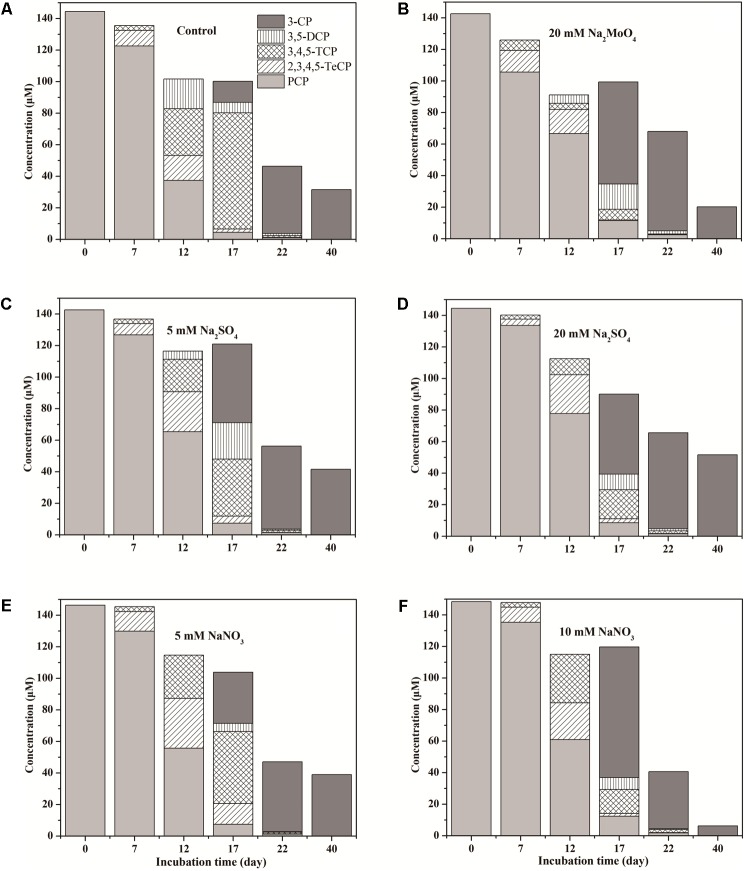
Dynamics of PCP dechlorinated metabolites in treatments of Control (A), 20 mM Na2MoO4
(B), 5 mM Na2SO4
(C), 20 mM Na2SO4
(D), 5 mM NaNO3
(E), and 10 mM NaNO3
(F).